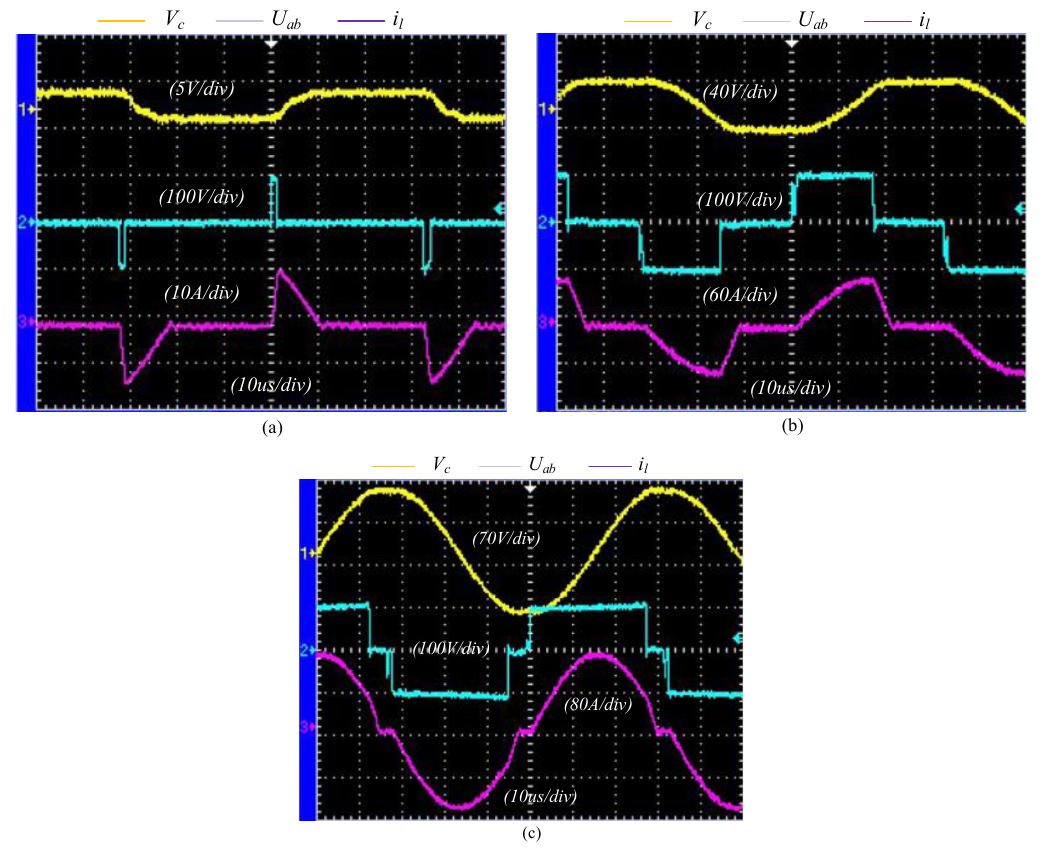
Figure 13. Experimental outcomes at duty ratios ( a ) 0.10 ( b ) 0.70 and ( c ) 0.9. The power was measured at the input and output ends by employing a DC meter.